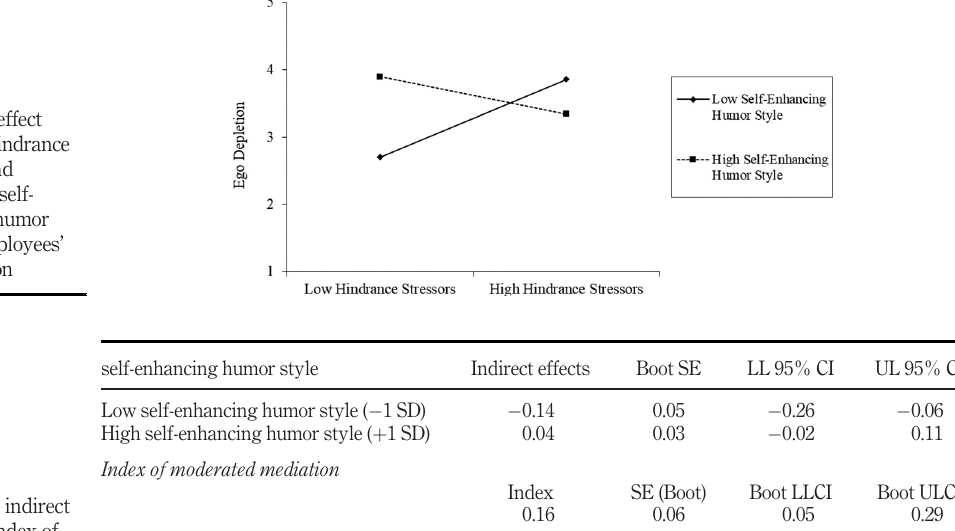
Table 3. Conditional indirect effect and index